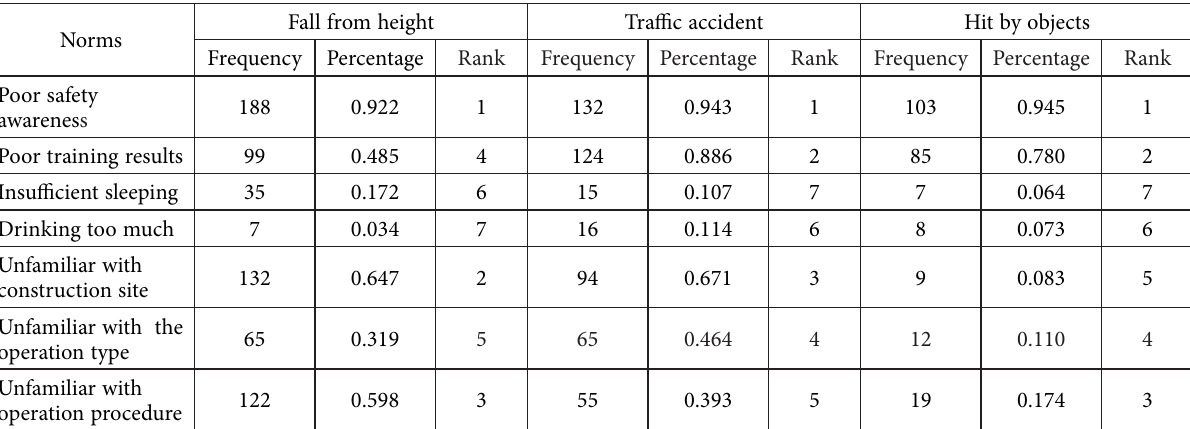
Table 9a. The norms of factor “personal readiness” (main norms)